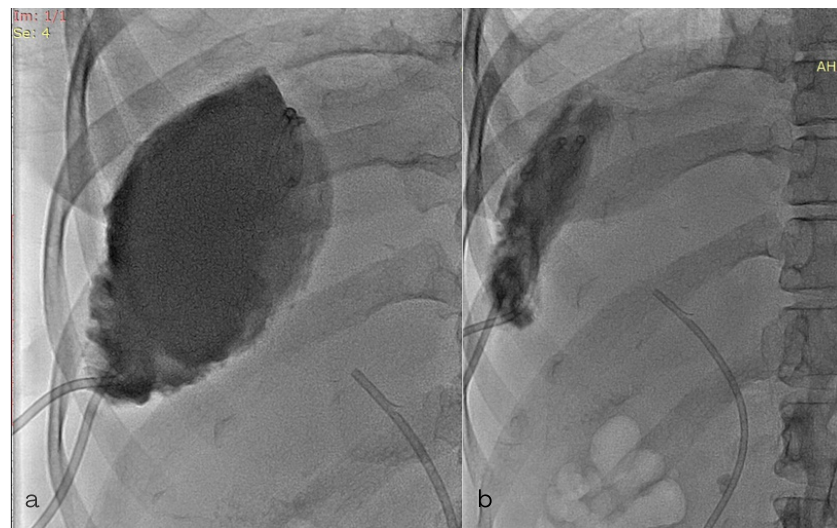
Figure 5. ( a , b ) Contrast opacification of the subcapsular collection through the 8F pigtail.